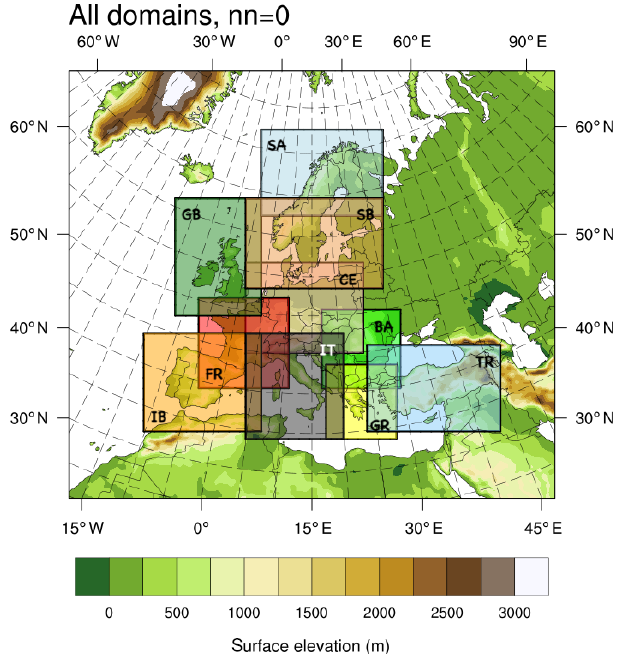
Figure 1. The WRF modelling domain with 10 subdomains used in the production of the New European Wind